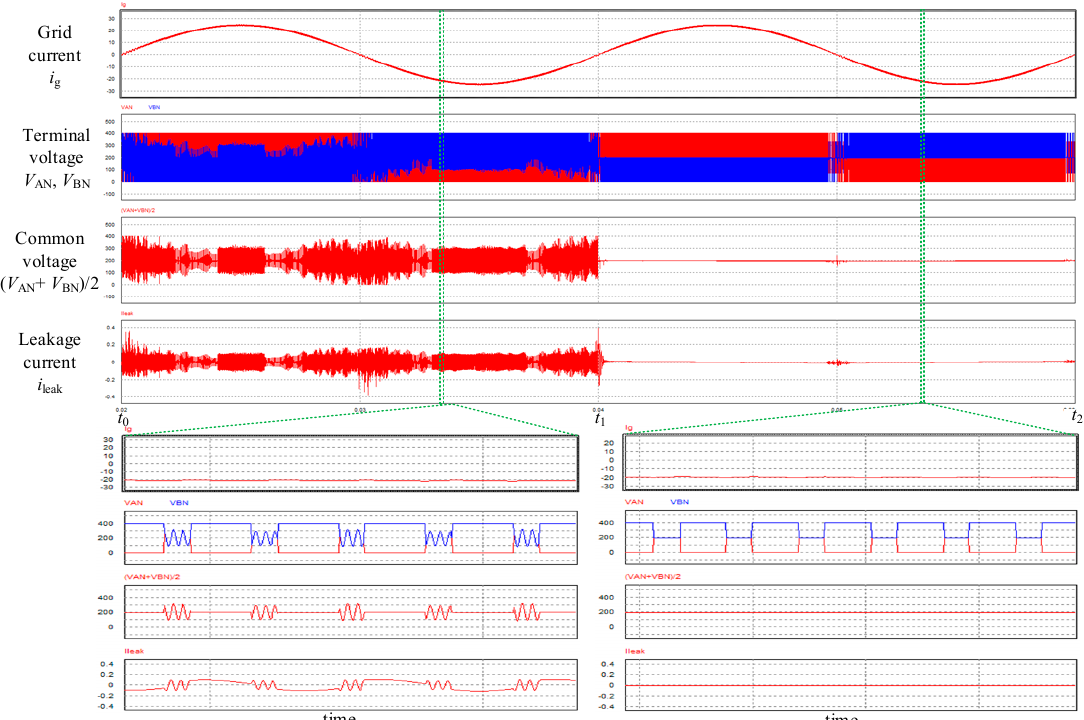
Figure 32. Waveforms of grid current, terminal voltage, CM voltage and leakage current.